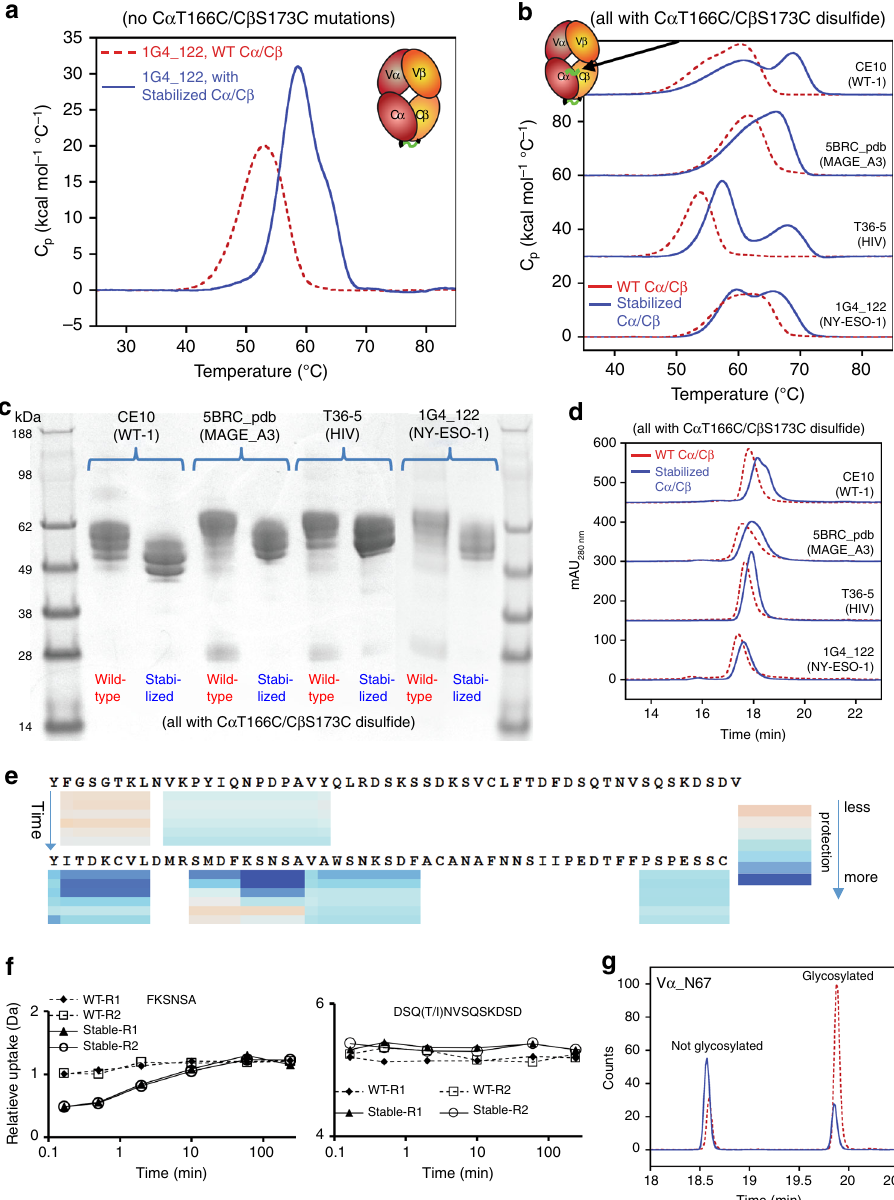
Fig. 4 Characterization of four diverse α / β TCRs with and without a stabilized C α /C β subunit. a DSC curves of the 1G4_122 TCR with zero (WT, dotted red line) or seven (solid blue line) stabilizing C α /C β mutations in the absence of the α 166/ β 173 stabilizing disul fi de. b DSC curves, ( c ) non-reduced SDS- PAGE, and ( d ) analytical SEC of four, diverse TCRs with zero (WT, dotted red line) or seven (solid blue line) stabilizing mutations all in the presence of the α 166/ β 173 disul fi de. e The only signi fi cant areas of backbone protection from deuterium exchange were in C α . The heat map under each peptide region indicates the level of protection observed at 10 s, 30 s, 2 min, 10 min, 1 h, and 4 h. Lack of a heat map indicates no signi fi cant differences in deuterium exchange observed in the region. f Deuterium uptake plots of peptides from the wild-type CE10 TCR and stabilized CE10 TCR. The experiment was performed in duplicate and both results of the two experiments are shown on the plots denoted as replicate 1 (R1) or replicate 2 (R2). g Extracted ion chromatograms of the peptide containing the V α _N67 N-linked glycosylation site. The peptide at 18.6 min was not glycoylsated while the peak 19.9 min shows up after enzymatic deglycosylation/conversion to Asp. The peptide from the wild-type TCR is a red dotted line and the peptide from the stabilized TCR is a solid blue line. Source data are available in the Source Data fi